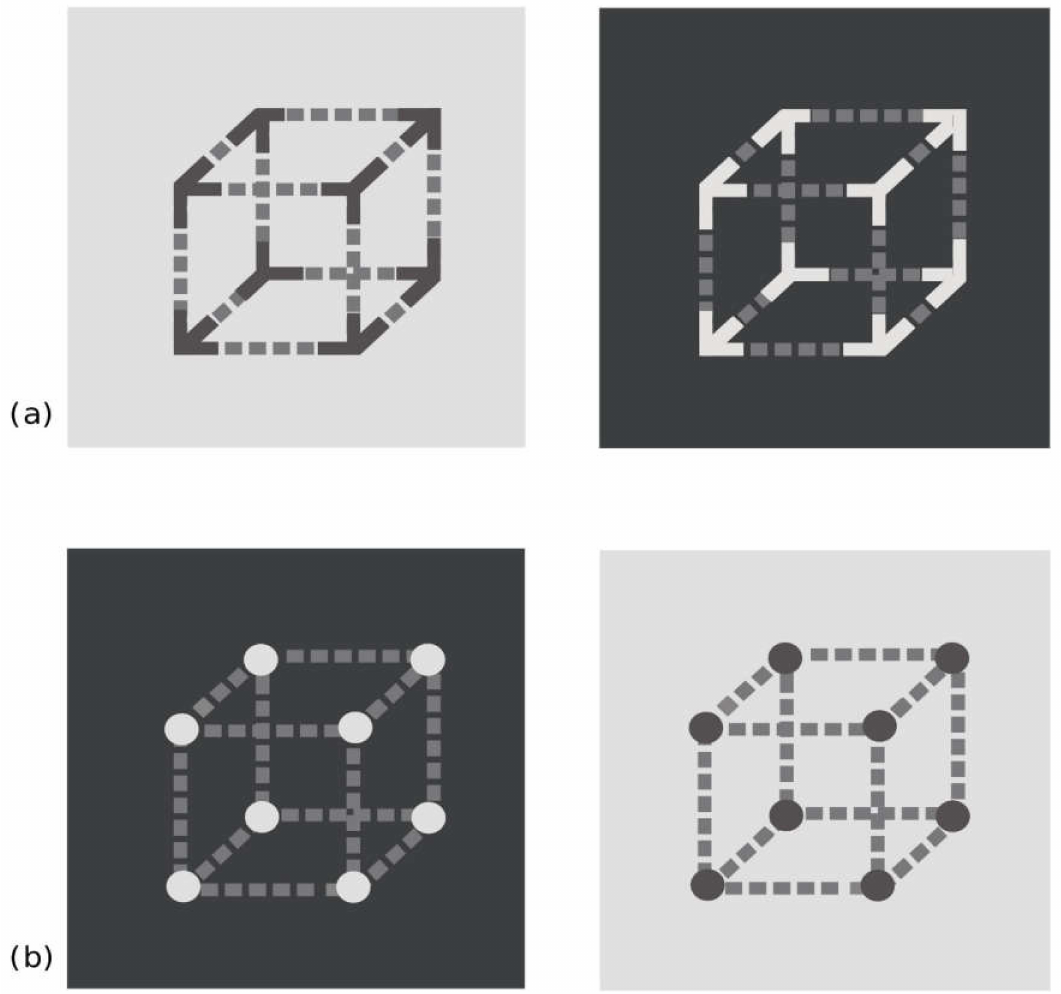
Figure 2. ( a ) Agostini and Galmonte [24] original reversed contrast Necker Cube; ( b ) same configuration with occluding disks instead of the inducer corners (control condition): removing the global belongingness / grouping factor, the e ff ect is inverted to simultaneous lightness contrast.